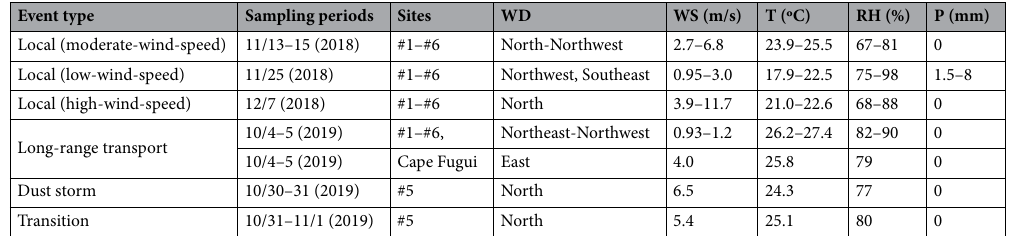
Table 1. Table of sampling periods, sampling sites, and sampling parameters for each event. WD: wind direction; WS: averaged wind speed; T: temperature; RH: relative humidity; P: precipitation. Meteorological data at each site is available on the EPA environmental resource database and Central Weather Bureau in